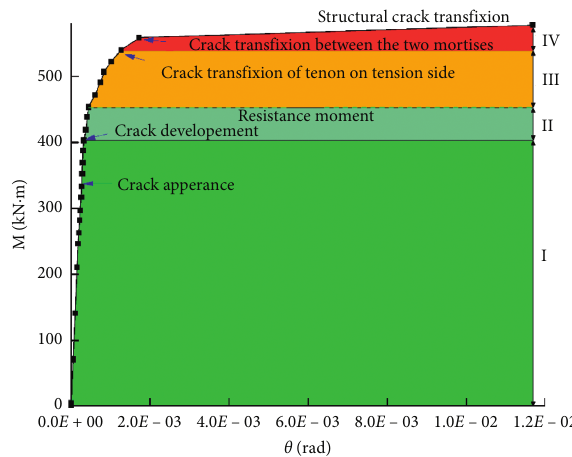
Figure 9: Relationship of crack development and bearing char- acteristic curve for double mortise-tenon